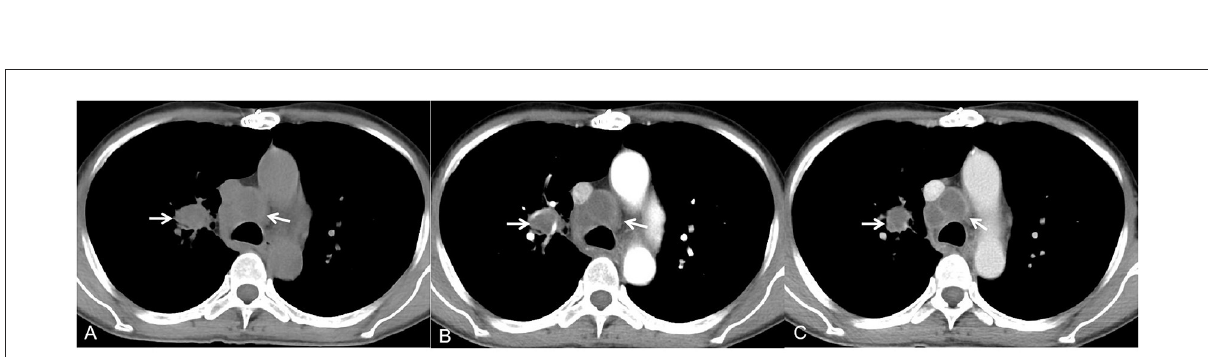
FIGURE2 A 59-year-old man with rheumatic heart disease and recurrent cough, sputum and malaise for 3 months. The mediastinal window of the axial non-contrast-enhanced CT image showed multiple enlarged lymph nodes in the right hilus pulmonis and mediastinum [ (A) , white arrow]. Contrast-enhanced CT images showed lymph nodes with rim low enhancement [ (B,C) , white